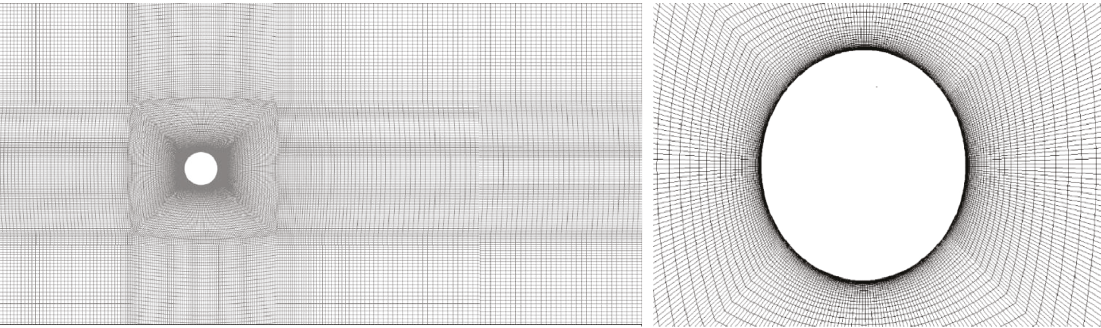
Figure 3: Computational mesh around the